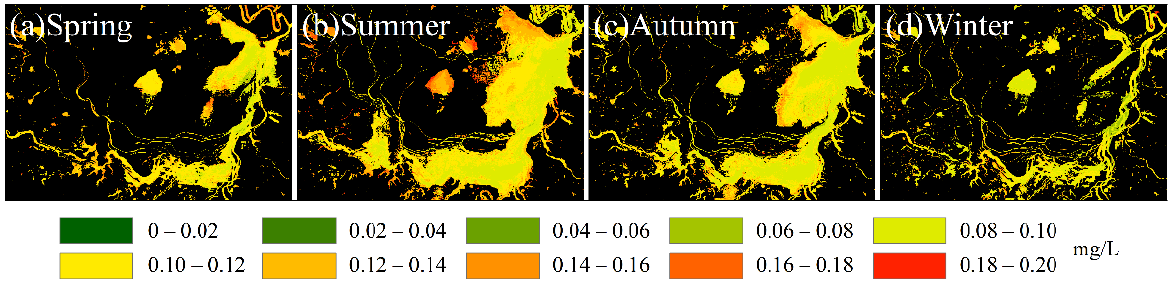
Figure 7. Quarterly composite image of TP content in Dongting Lake.